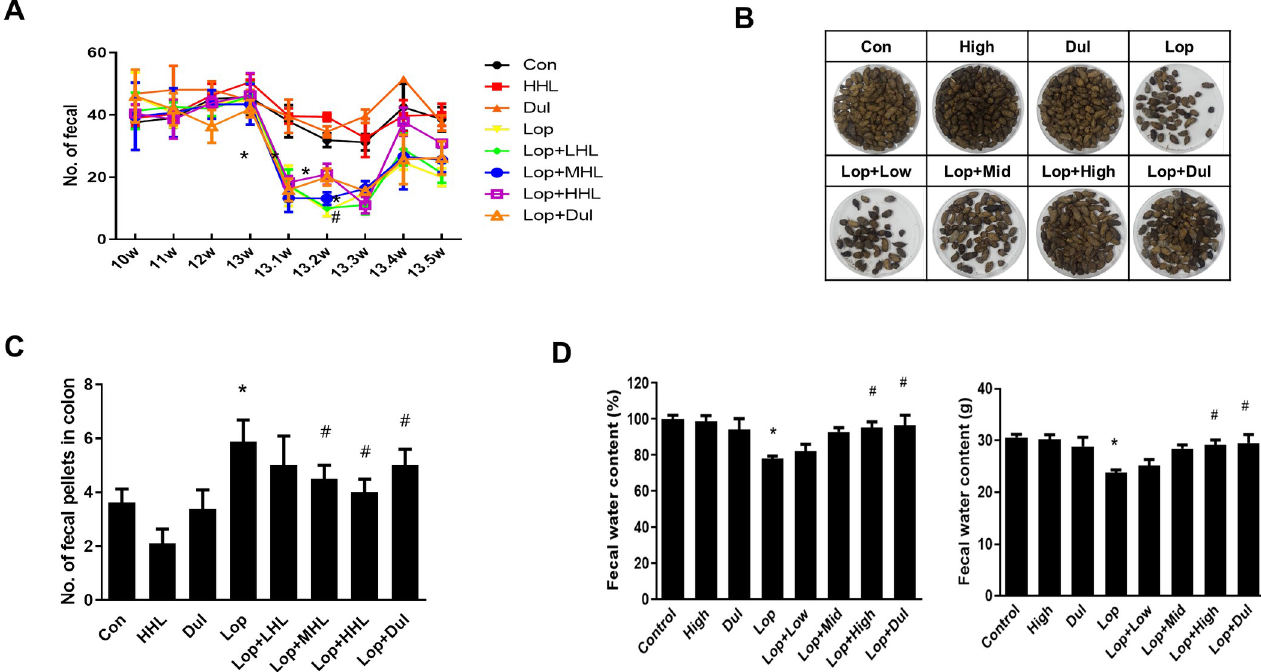
Fig 1. Effect of HLp-nF1 on constipation parameters. Eight-week-old male rats were treated with loperamide along with 3.2 × 10 10 , 8 × 10 10 , and 1.6 × 10 11 cells/mL HLp-nF1, and Dulcolax individually. A single treatment with 1.6 × 10 11 cells/mLHLp-nF1 or Dulcolax was used as the control group. ( A ) The fecal pellets were counted at the indicated time points. ( B ) The fecal pellets collected prior to sacrifice, ( C ) the number of remaining fecal pellets in the colon, and ( D ) fecal water content is shown. Each value represents the mean ± SD. A t-test was used to determine the means of two groups ( n = 11 ). � P < 0.05 vs. control group, # P < 0.05 vs. loperamide-treated group. Con , control group; Lop , loperamide-treated group; Dul , Dulcolax-treated group (0.75 mg/kg); HHL , treatment with 1.6 × 10 11 cells/mL HLp-nF1; Lop+LHL , treatment with loperamide and 3.2 × 10 10 cells/mL HLp-nF1; Lop+MHL , treatment with loperamide and 8 × 10 10 cells/mL HLp-nF1; Lop+HHL , treatment with loperamide and 1.6 × 10 11 cells/mL HLp-nF1; Lop+Dul treated group.